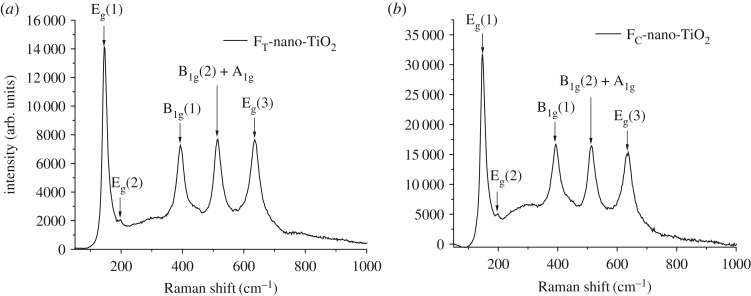
Raman spectra of organofunctionalized nano-TiO2, (a) FT-nano-TiO2 and (b) FC-nano-TiO2 at room temperature.